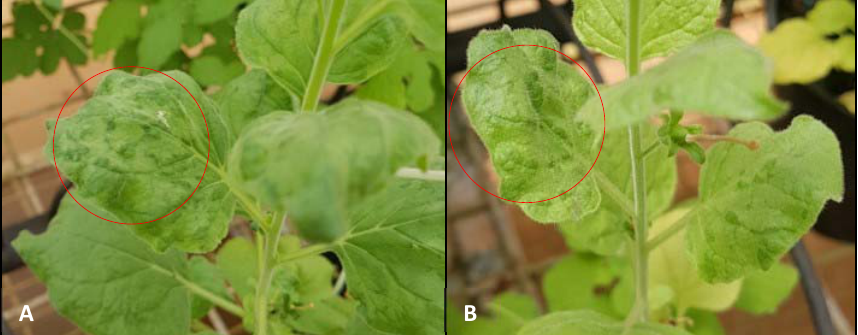
Figure 2. Symptomology (Red circles) of CGMMV on N. benthamiana planted into infested soil treated with ( A ) 2% Virkon TM and ( B ) untreated soil.